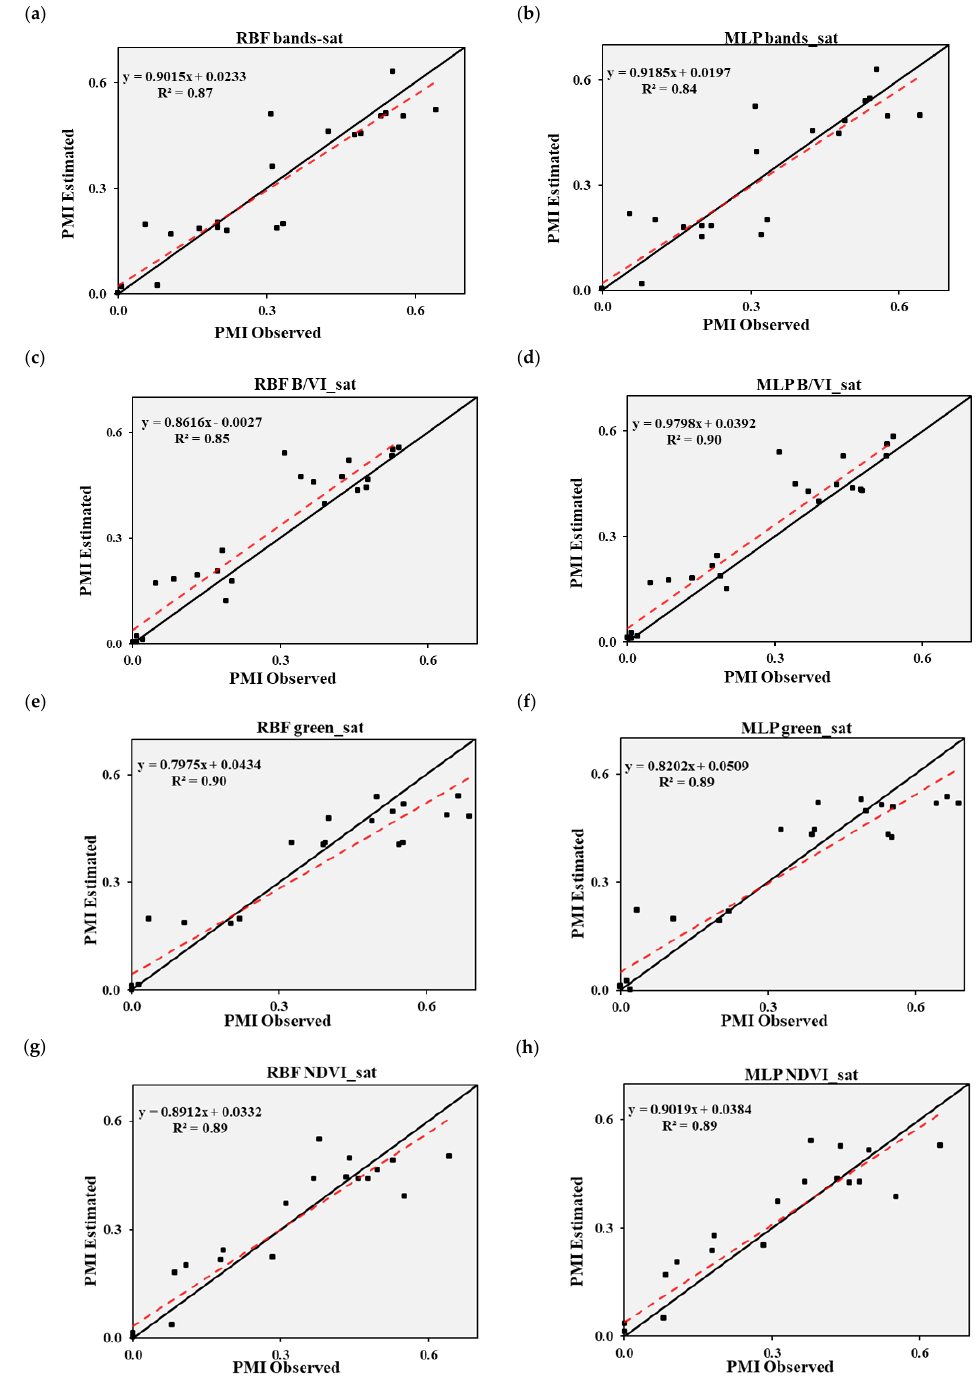
Figure 5. Performance of the satellite data for the models using the variables that showed the best accuracy (MAE) for the two neural networks (RBF and MLP). ( a , c , e , g ) refer to models with the RBF network, while the letters ( b , d , f , h ) refer to models of the MLP network.